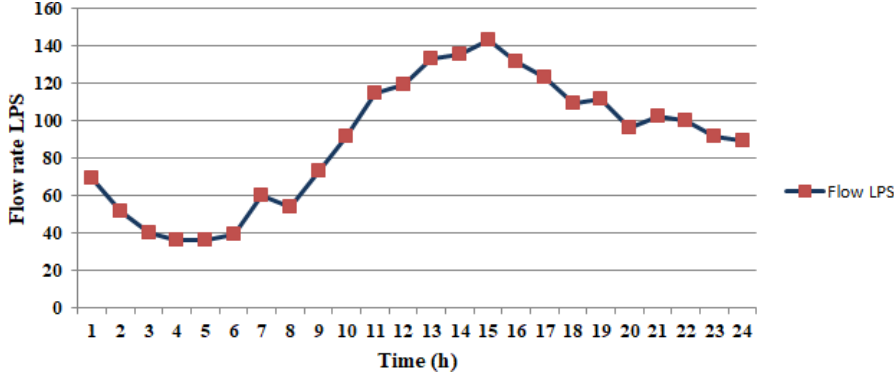
Figure 2. Daily average water demand of the study area.